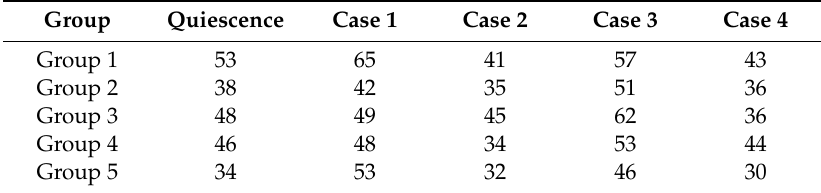
Table 4. Salivary amylase activity level in di ff erent illumination environments (KU / L).